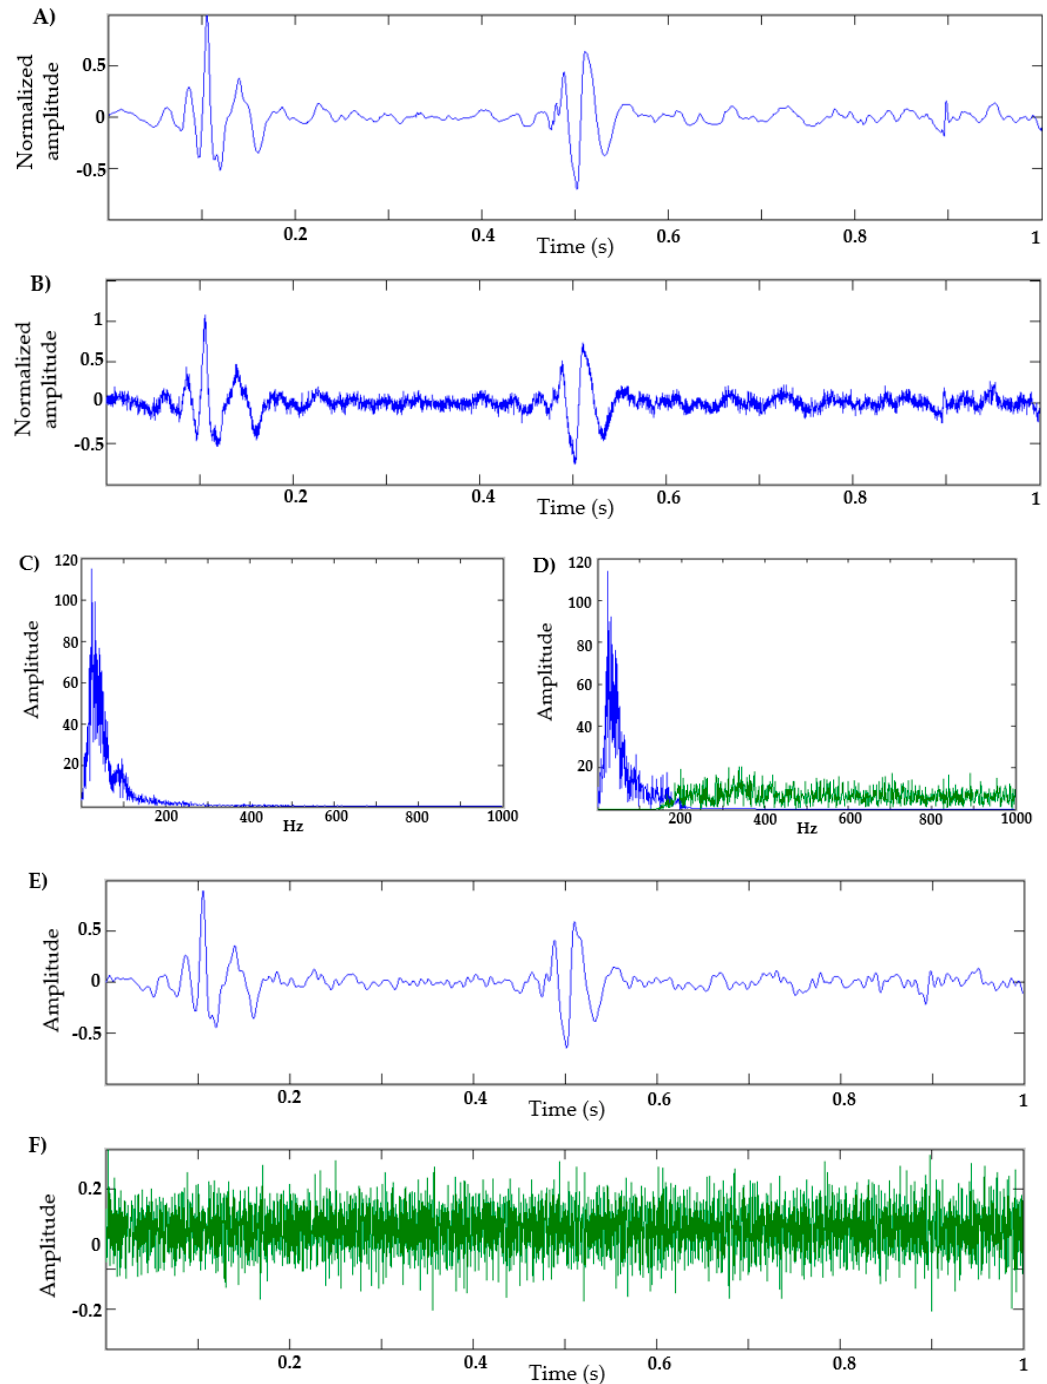
Figure 7. ( A ) Real heart sound; ( B ) real heart sound with Gaussian noise; ( C ) Fourier transform (FFT) of real heart sound; ( D ) FFT of heart sound with Gaussian noise; ( E ) empirical wavelet transform (EWT) component of the noisy signal in the frequency range of 0–200 Hz; ( F ) EWT component of the noisy signal in the frequency range greater than 200 Hz.